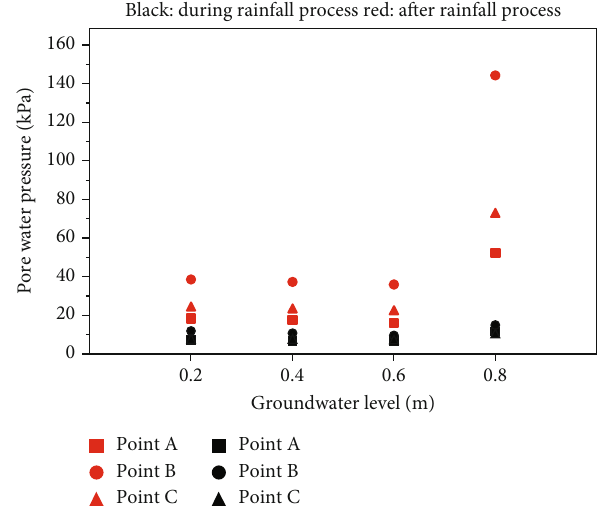
Figure 9: The maximum pore water pressure at slope reference points A, B, and